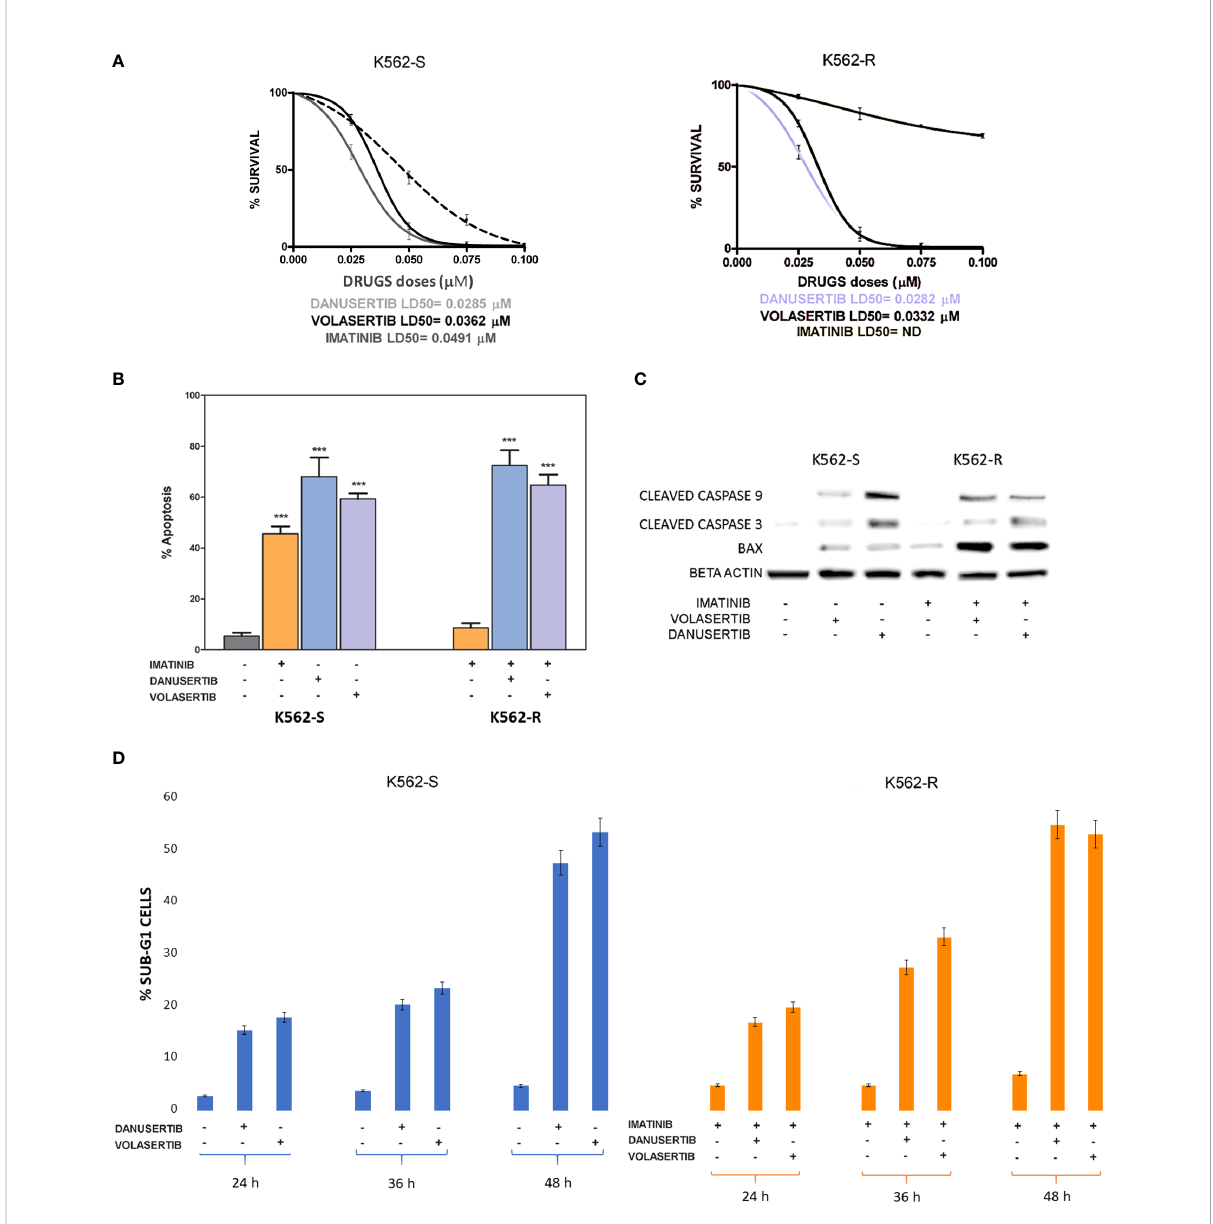
FIGURE 1 Effects of Aurora kinase A and PLK1 inhibition on CML cell proliferation. (A) Dose-dependent inhibition of K562S (left panel) and K562R (right panel) cells in 14-days methylcellulose colony-forming assays. Cells were treated with increasing concentrations of imatinib, danusertib (Aurora kinase A inhibitor) and volasertib (PLK1 inhibitor). Danusertib treatment is represented by the grey line, volasertib is represented by the dark line and imatinib by the dotted line (B) Flow cytometry analysis of Annexin-V/PI positive cells. K562S and K562R cells were treated with imatinib